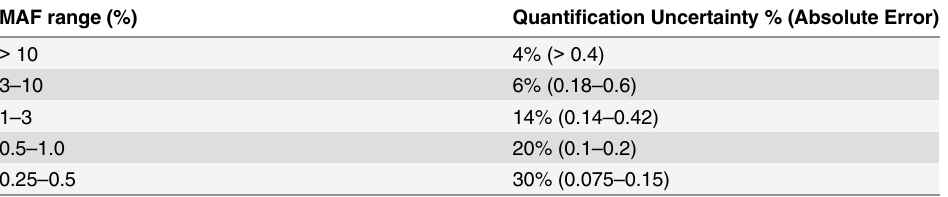
Table 2. Mutant Allele Frequency measurement accuracy. Quantification uncertainty varies inversely with single nucleotide variant MAF, with the highest relative uncertainty at lower MAF and least percent rela- tive uncertainty at higher